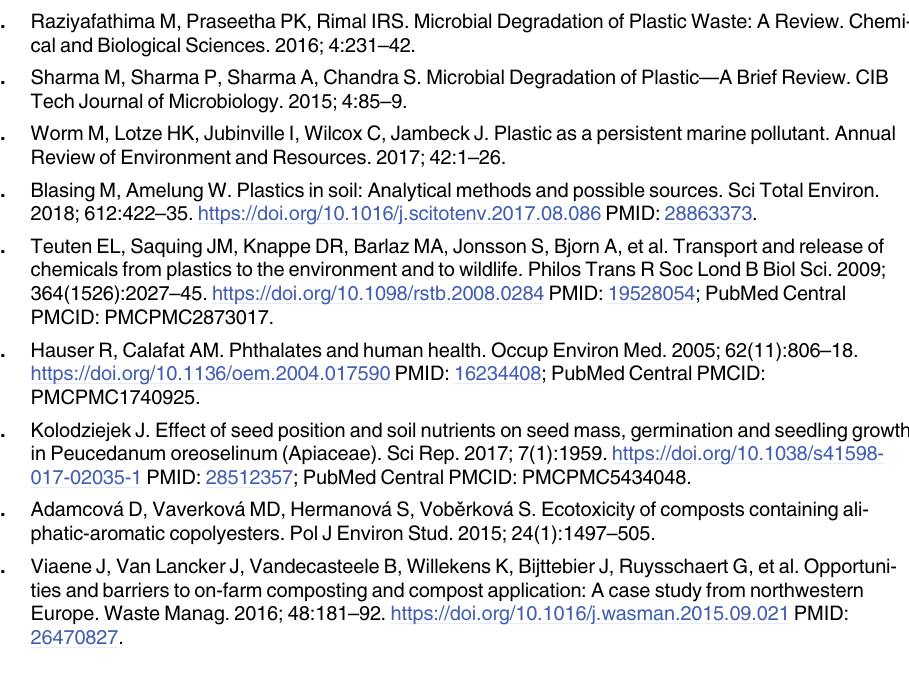
S12 Table. Associations common to both bulk and plastic-associated compost microbial community co-occurrence